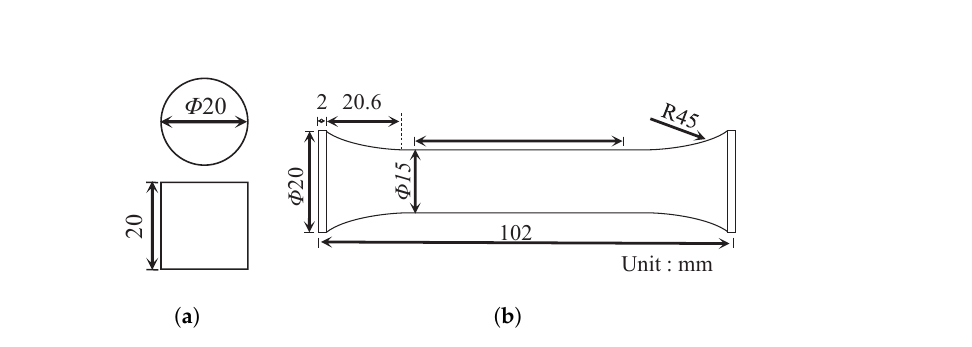
Figure 3. Geometry and dimension of the specimen. ( a ) The compression specimen, and ( b ) the tension specimen.